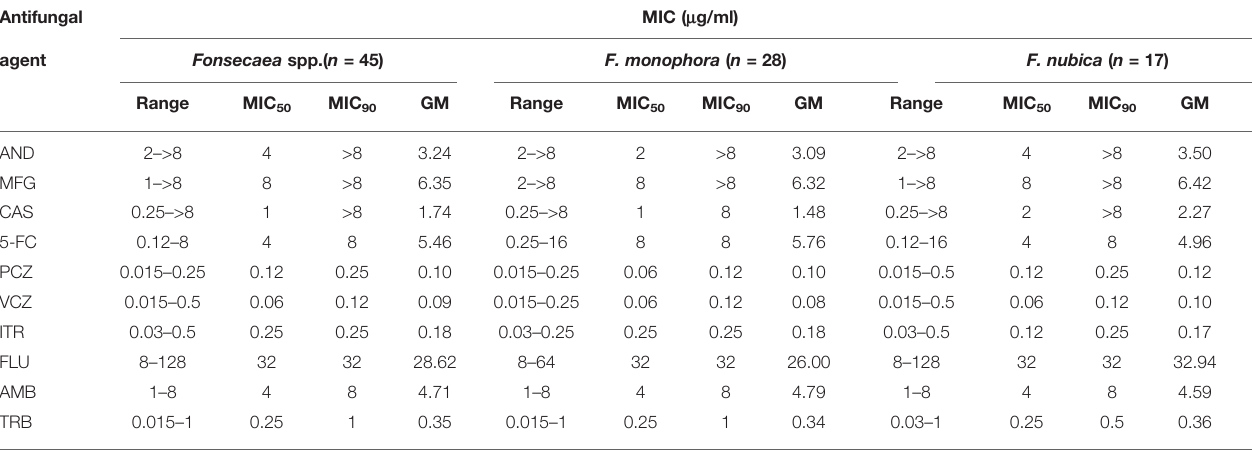
TABLE 3 | Minimal inhibitory concentrations (MIC) of 10 antifungal agents against 45 clinical isolates of Fonsecaea spp.